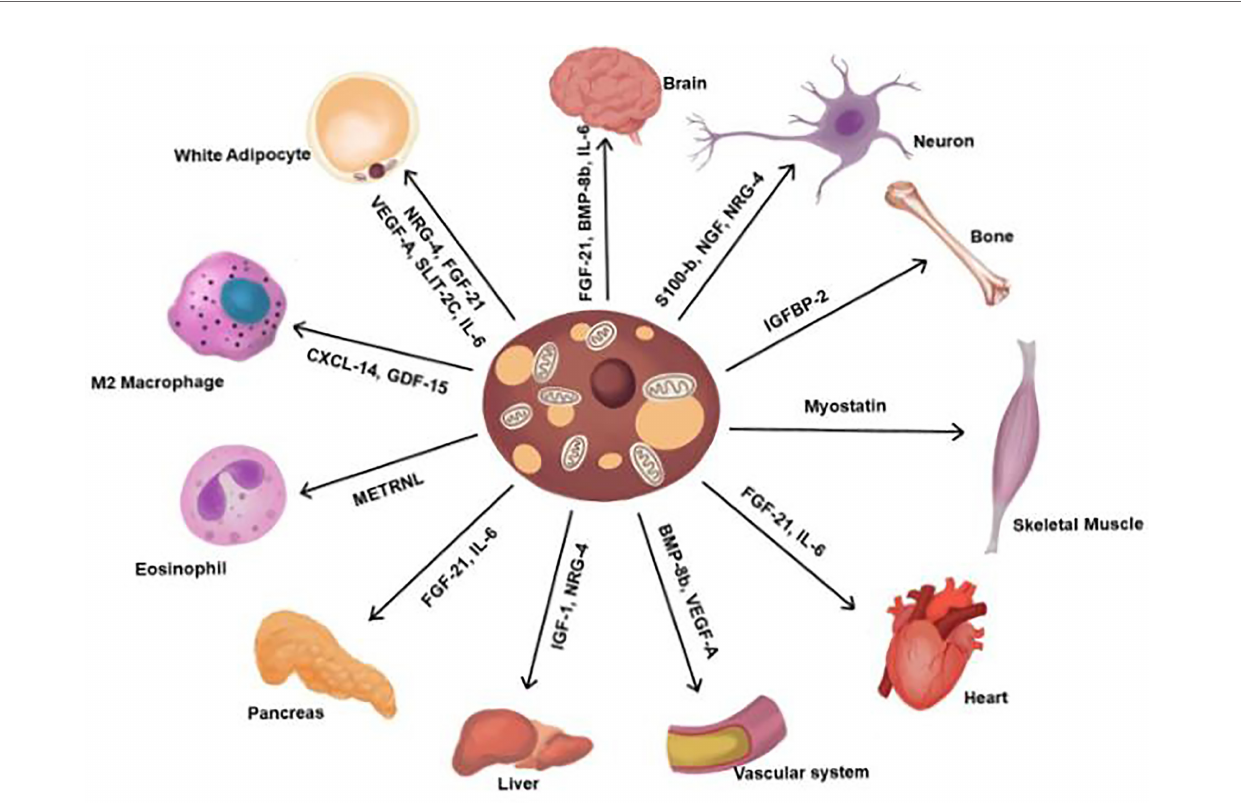
FIGURE 2 | Adipokines secreted from BAT. Contribute to the regulation of various functions. FGF-21, fi broblast browth factor 21; BMP-8b, bone morphogenetic protein 8b; IL-6, interlukin-6; NGF, nerve growth factor; NRG-4, neuregulin 4; IGFBP2, insulin-like growth factor-binding protein 2; VEGF-A, vascular endothelial growth factor A; IGF-1, insulin growth factor-1, METRNL, meteorin-Like; CXCL14, chemokine (C-X-C motif) ligand 14; GDF-15, Growth and differentiation factor 15; SLIT2-C, C-terminal fragment of